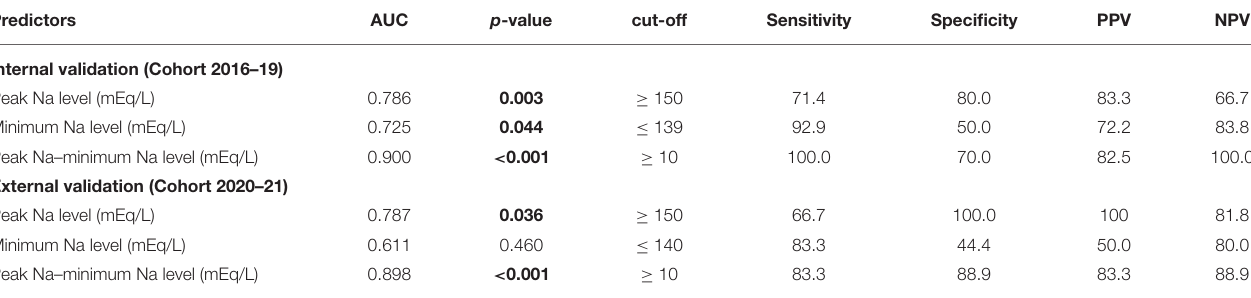
TABLE 4 | The performance of predictors of requiring desmopressin prescription at